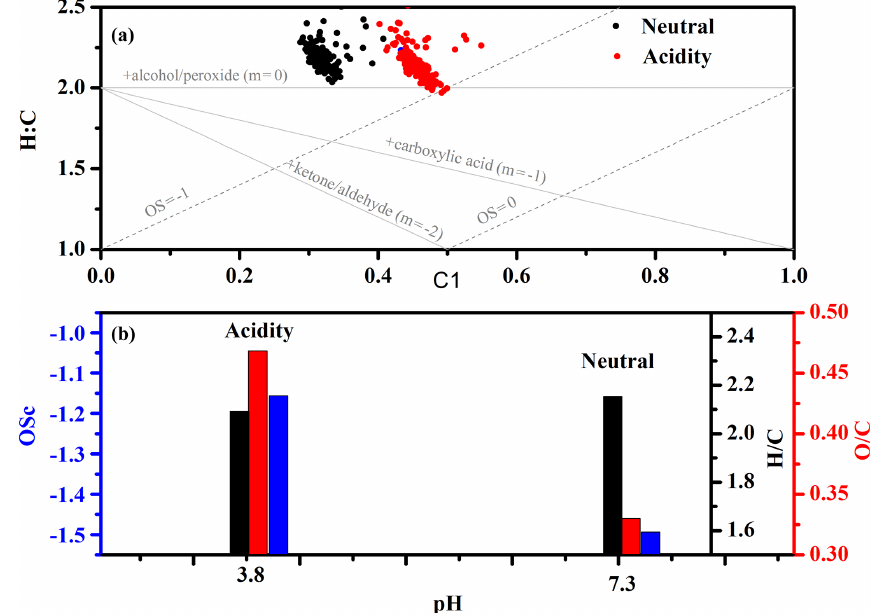
Figure 6. Van Krevelen diagrams of elemental ratios under different seed particle acidity (a) ; change in H / C ratio (black), O / C ratio (red), and OS c (blue) with particle acidity (b)